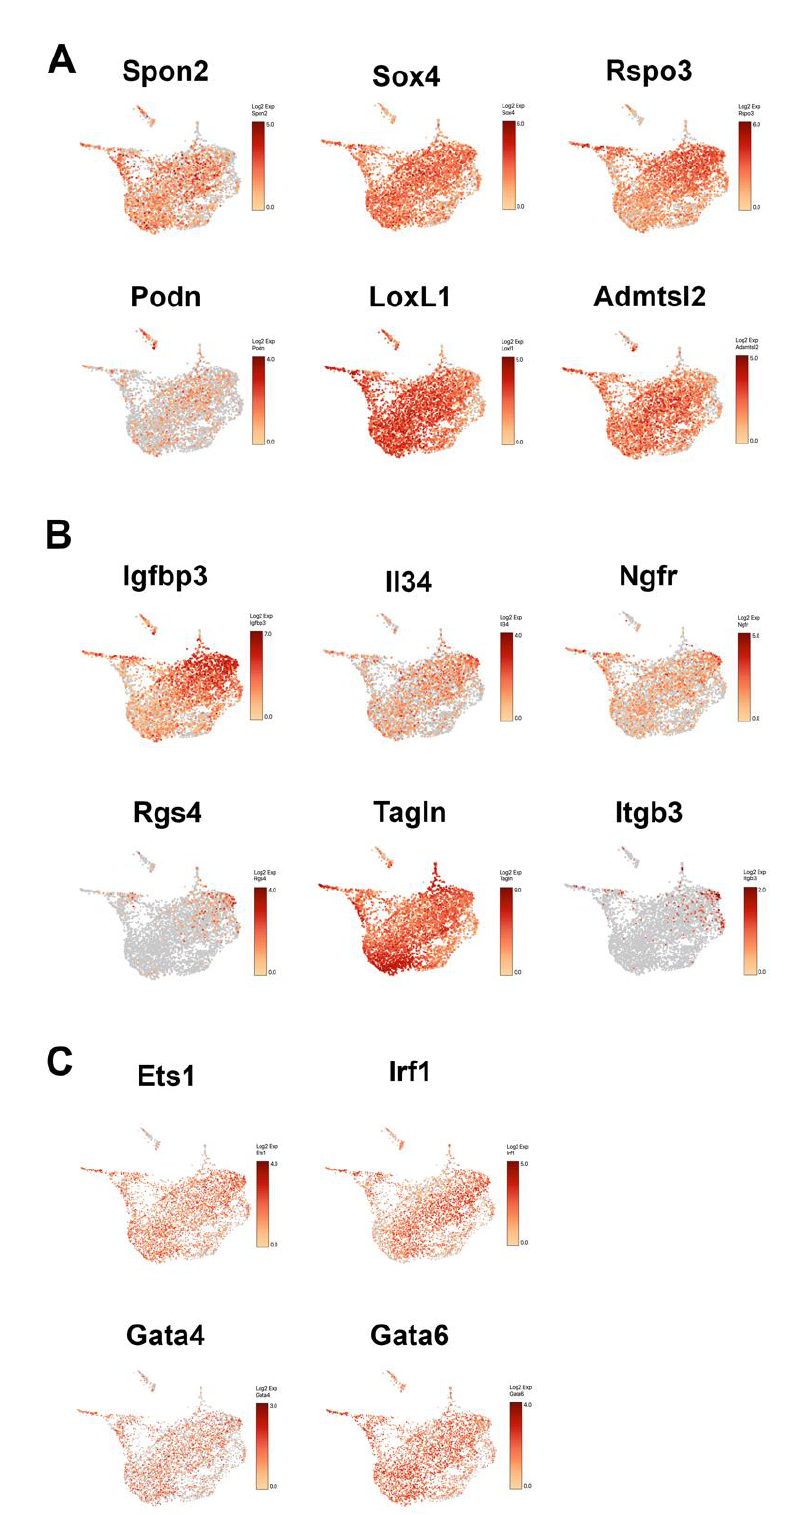
Figure 6. The comparison of the expression of CV HSC markers and PV HSC markers in HSC subtypes. ( A ) Representative UMAP Loupe images of the expression pattern of the selected CV HSC marker genes. Each dot represents a single cell. ( B ) Representative UMAP Loupe images of the expression pattern of the selected PV HSC marker genes. Each dot represents a single cell. ( C ) Representative UMAP Loupe images of the expression pattern of the selected HSC regulators, Ets1, Irf1, Gata4 and Gata6. Each dot represents a single